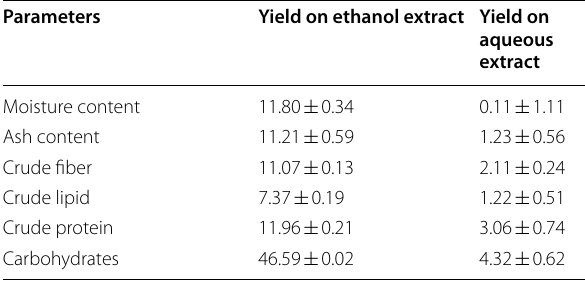
Table 3 Proximate analysis of aqueous and ethanol extracts